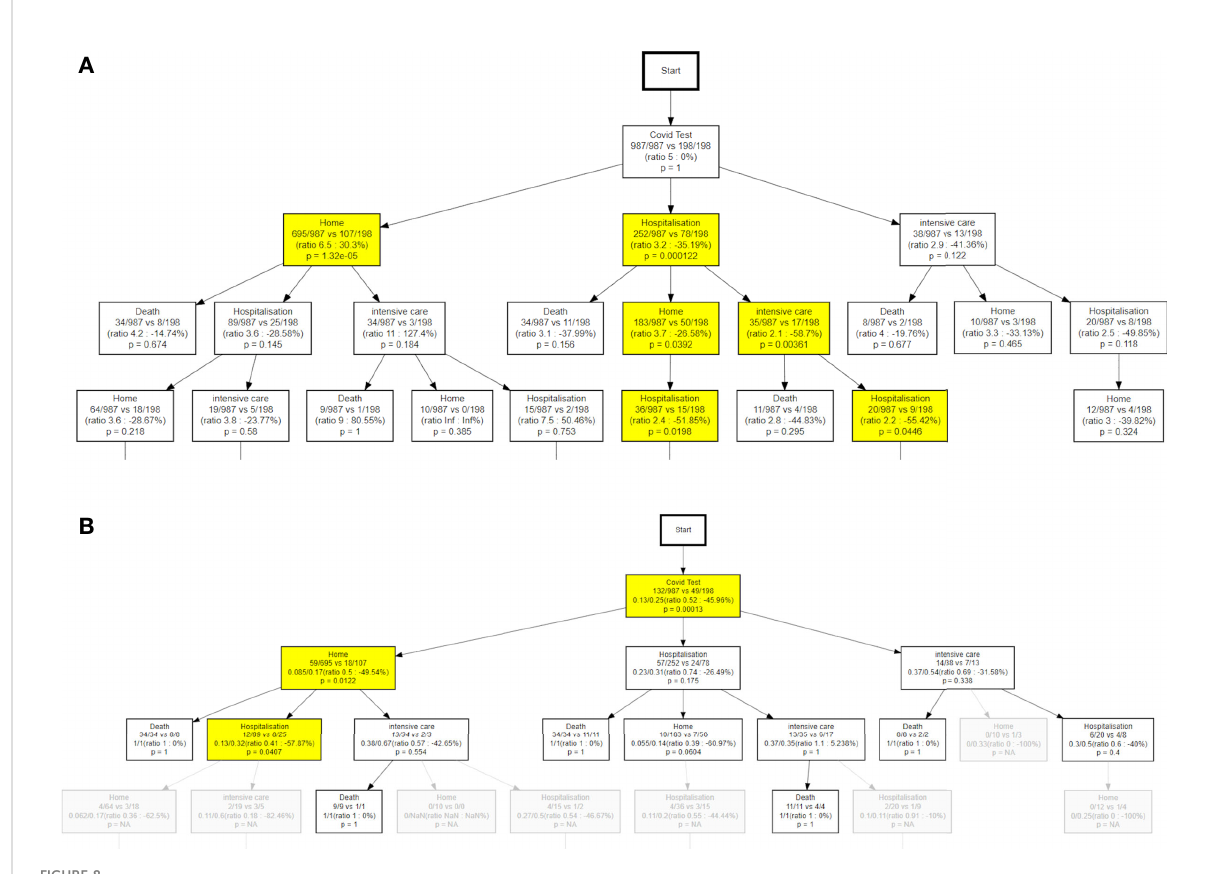
FIGURE 8 Time evolution of patient number percentages with respect to the total number of patients. (A) the solid lines represent the patients in the fi rst wave, and the dotted line the evolution of the patient in the second wave. (B) the solid lines show the evolution of patients without recent oncological treatment vs treatment-active